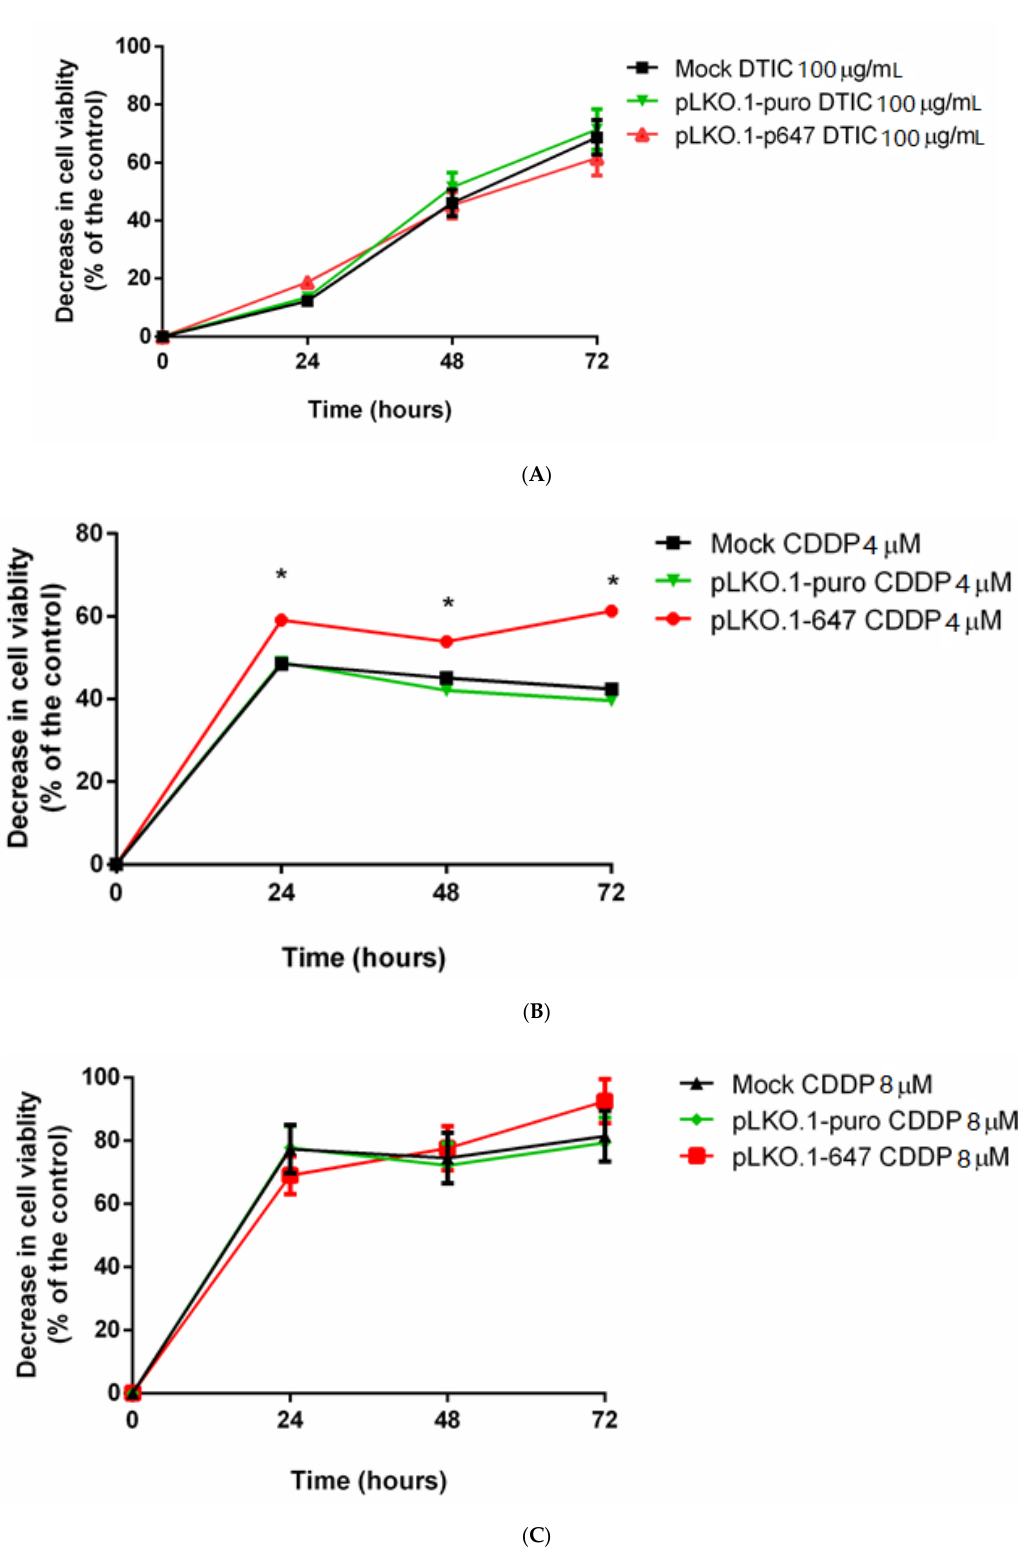
Figure 3. E ff ect of chemotherapeutic treatment on A375 cells. MTT assay was used to evaluate the e ff ect of dacarbazine (DTIC) (100 µ g / mL) (panel A ) and cisplatin (CDDP) (4 and 8 µ M) (panels B , C ) on cell viability of mock, samples treated with empty vector (pLKO.1-puro), and PON2 downregulating cells (pLKO.1-647). Measurements were performed at di ff erent time points (0, 24, 48, and 72 h). All values are expressed as mean ± standard deviation (* p <